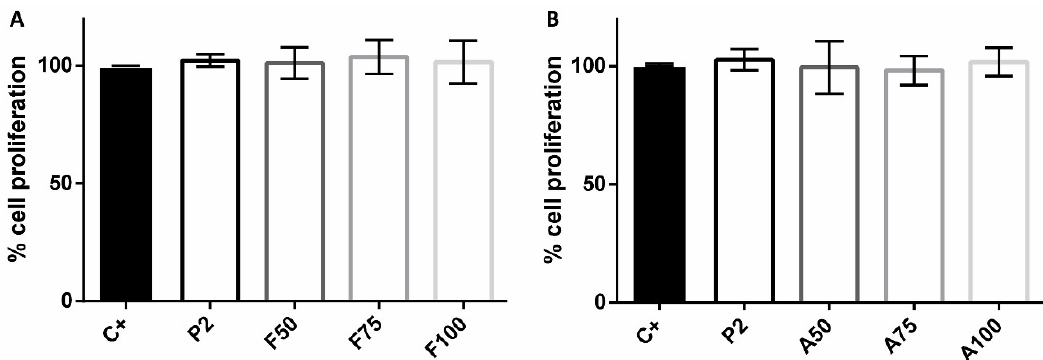
Figure 8. Percentage of MC3T3-E1 proliferation without treatment (positive control, C + ), or treated with P2 or with the fluconazole-loaded ( A ) or anidulafungin-loaded ( B ) sol–gel coatings. Bars represent mean and standard deviation of the percentage of cellular proliferation estimated in three biological replicates.